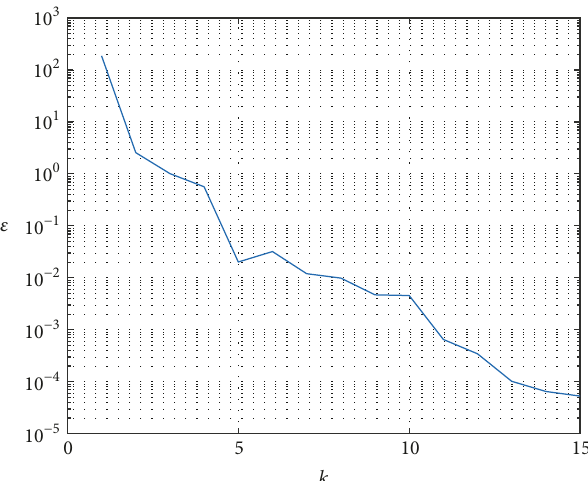
Figure3:Thedependencyoftheerror 𝜀 (10)ontheiterationnumber 𝑘 .